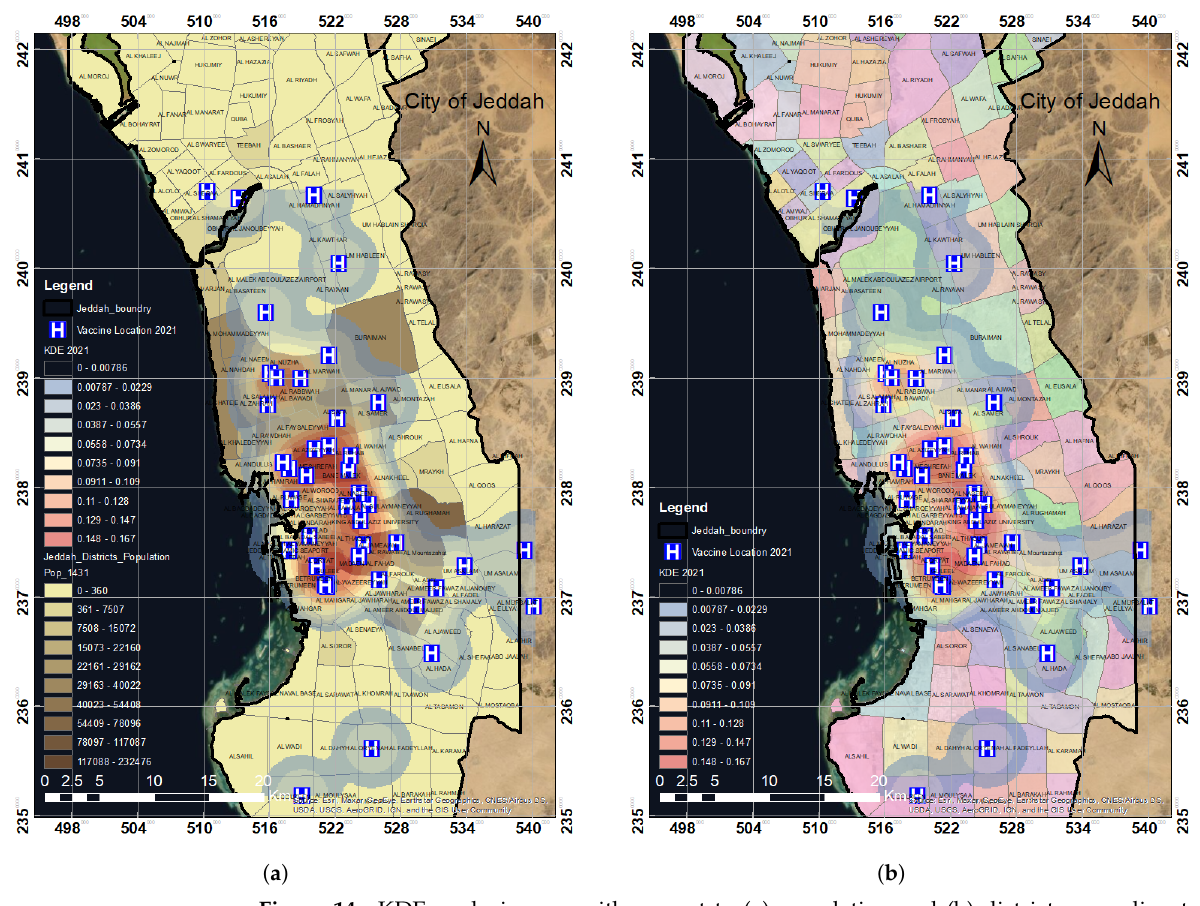
Figure 14. KDE analysis map with respect to (a) population and (b) districts according to the distribution of the COVID-19 vaccination centers in Jeddah in 2021. ( a ) KDE analysis map in relation to population data. ( b ) KDE analysis map in relation to district